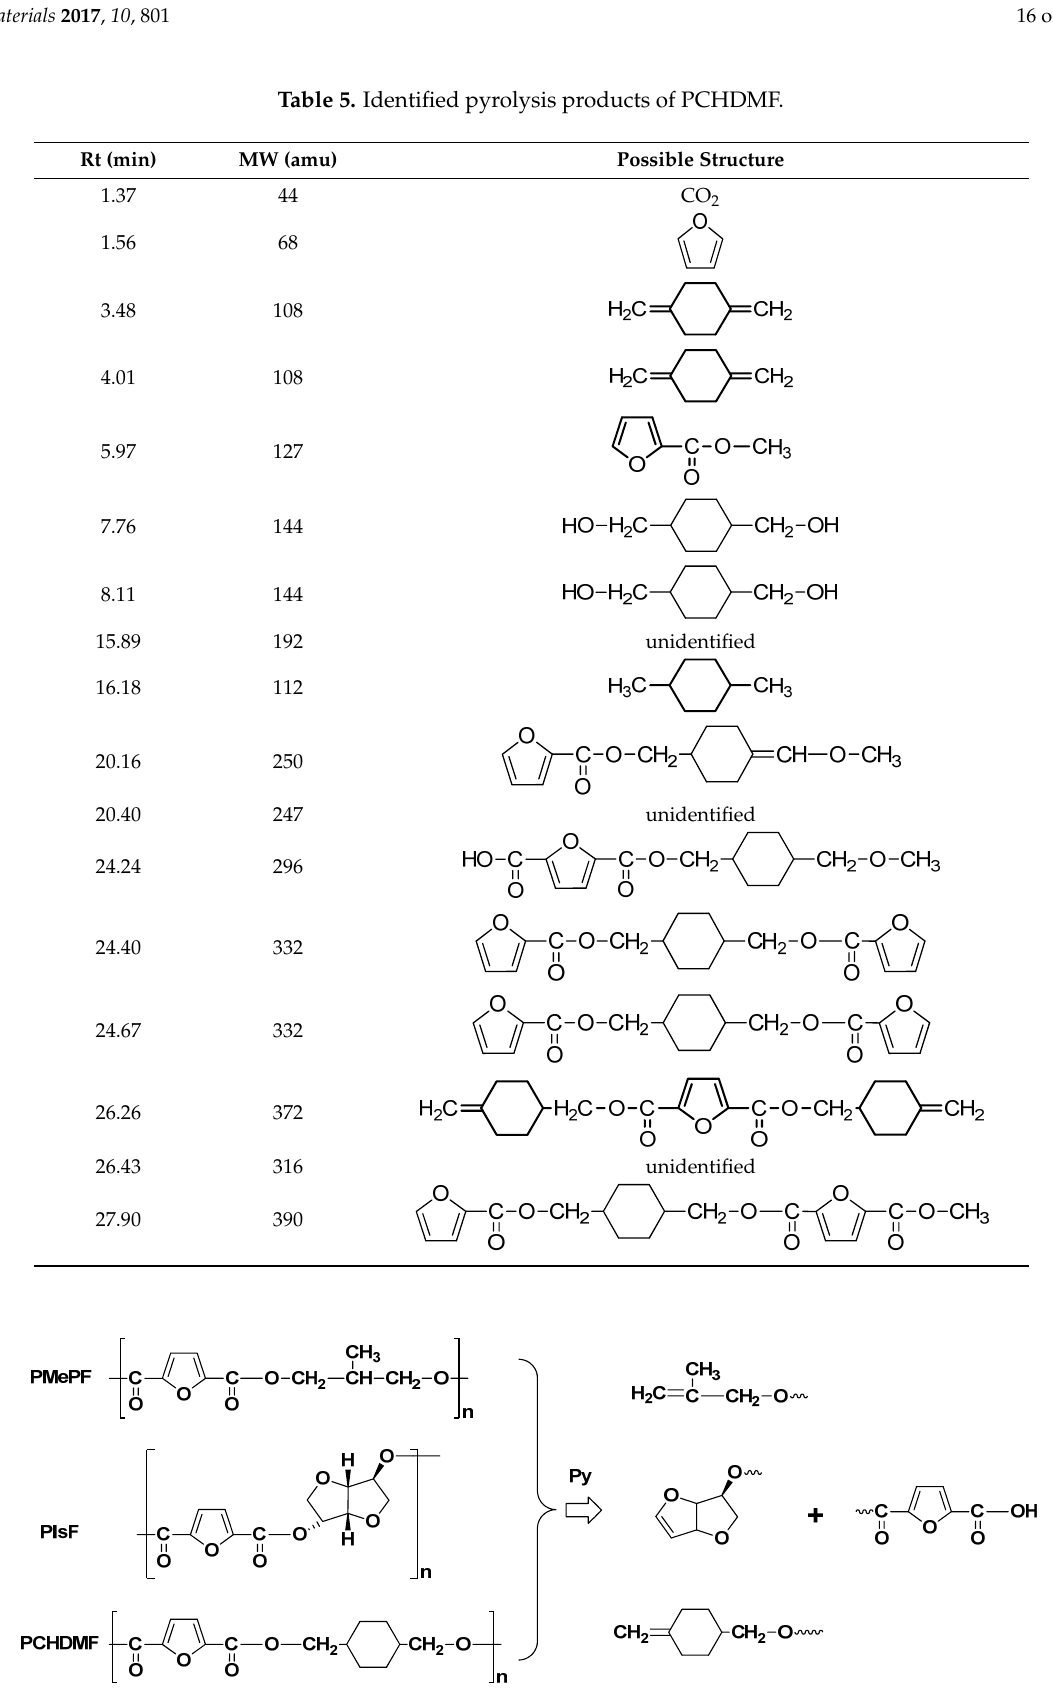
Table 3. Identified pyrolysis products of